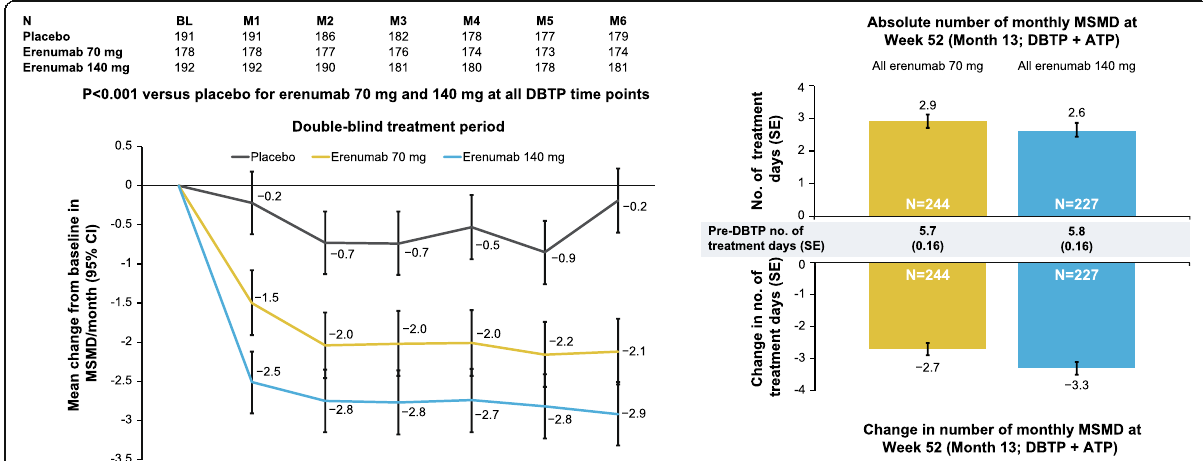
Fig. 2 Change in monthly MSMD over DBTP and ATP of the EM study in users of MSM at baseline. Baseline values are not adjusted analysis; DBTP results are presented as adjusted means and 95 % CIs utilizing a generalized linear mixed model which includes treatment, visit, treatment by visit interaction, stratification factors region and prior/current treatment with migraine prophylactic medication, and baseline value as covariates and assuming a first-order autoregressive covariance structure. P-values for pairwise comparisons are nominal p-values without multiplicity adjustment. ATP results are presented as mean ± SE. ‘ All erenumab 70 mg ’ in the ATP at Week 52 comprised patients with